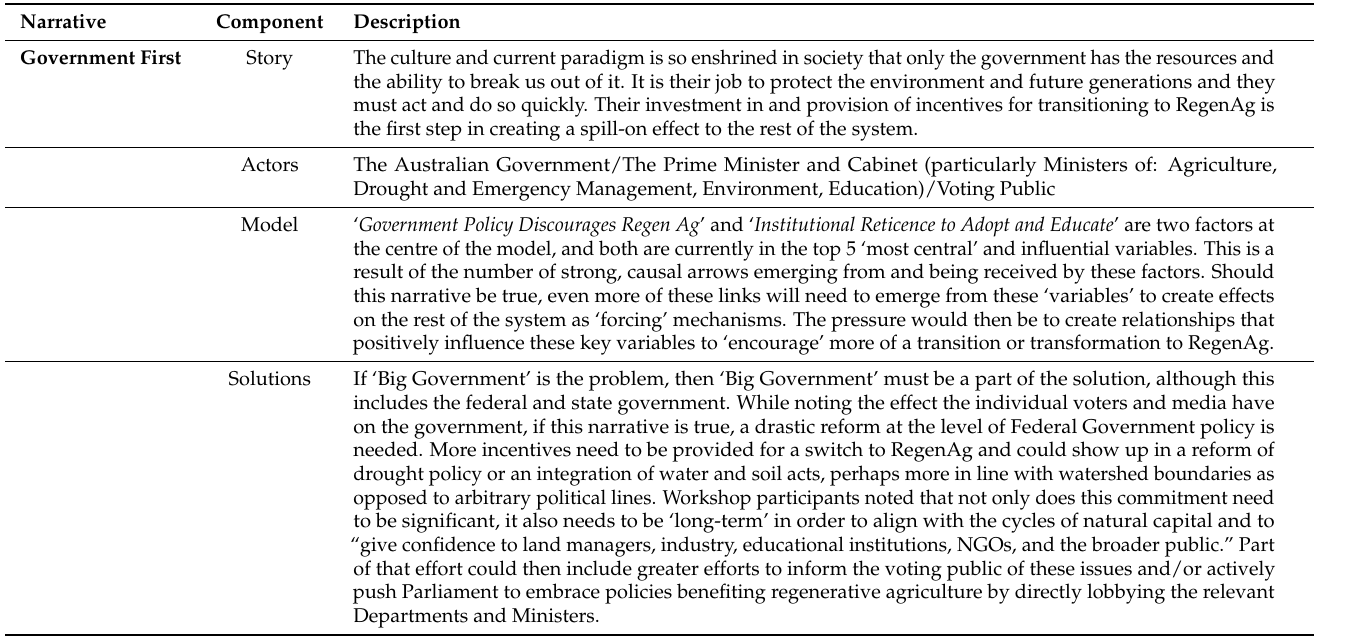
Table 3. Narrative 1: Government First.